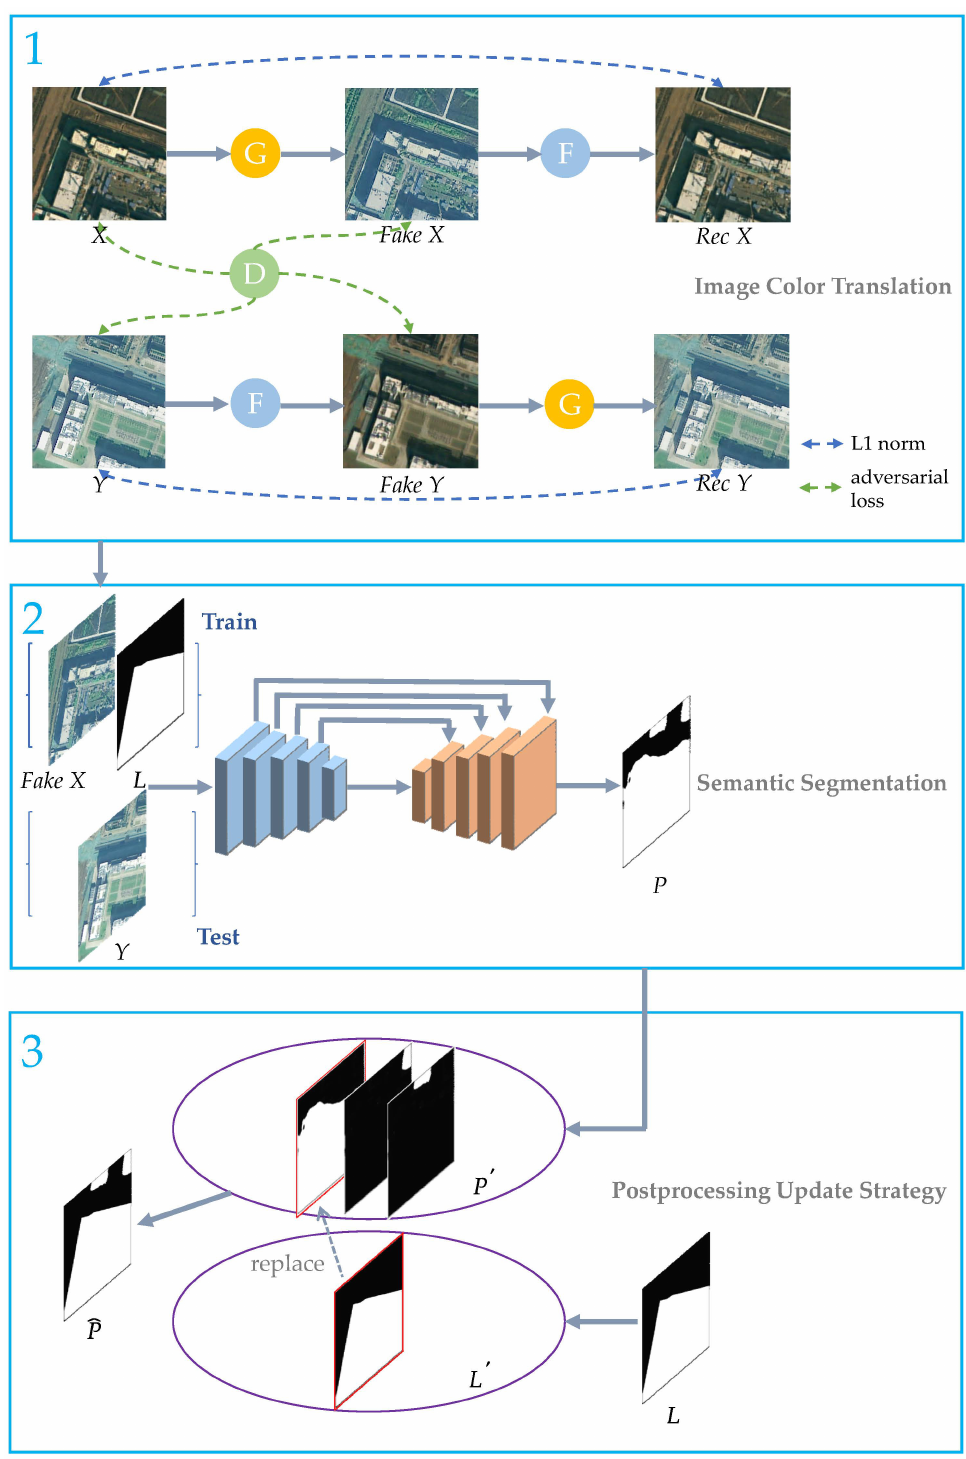
Figure 1. ( Top ) shows the image color translation method, which is used to generate pseudo-source domain images. ( Middle ) applies synthesized images to the semantic segmentation model to learn building information with the color distribution of the latest period. ( Bottom ) is the post-processing update strategy that is used to replace some predictions that meet the threshold